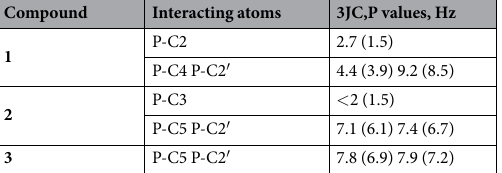
Table 5. Experimental and calculated (in parenthesis) averaged three-bond coupling constants 3JC,P for compounds 1–3 .